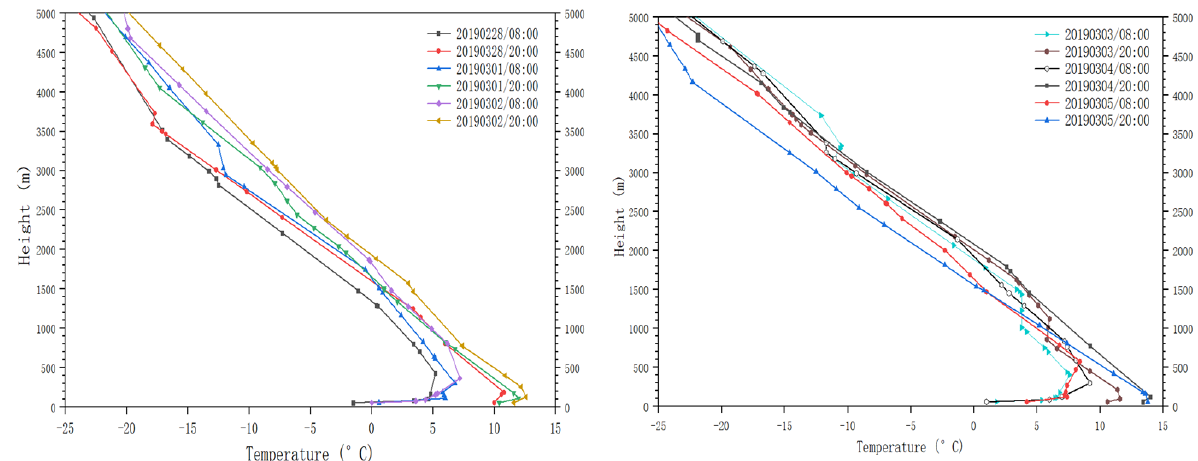
Figure 7. Vertical profiles of temperature in Beijing from 28 January to 5 March